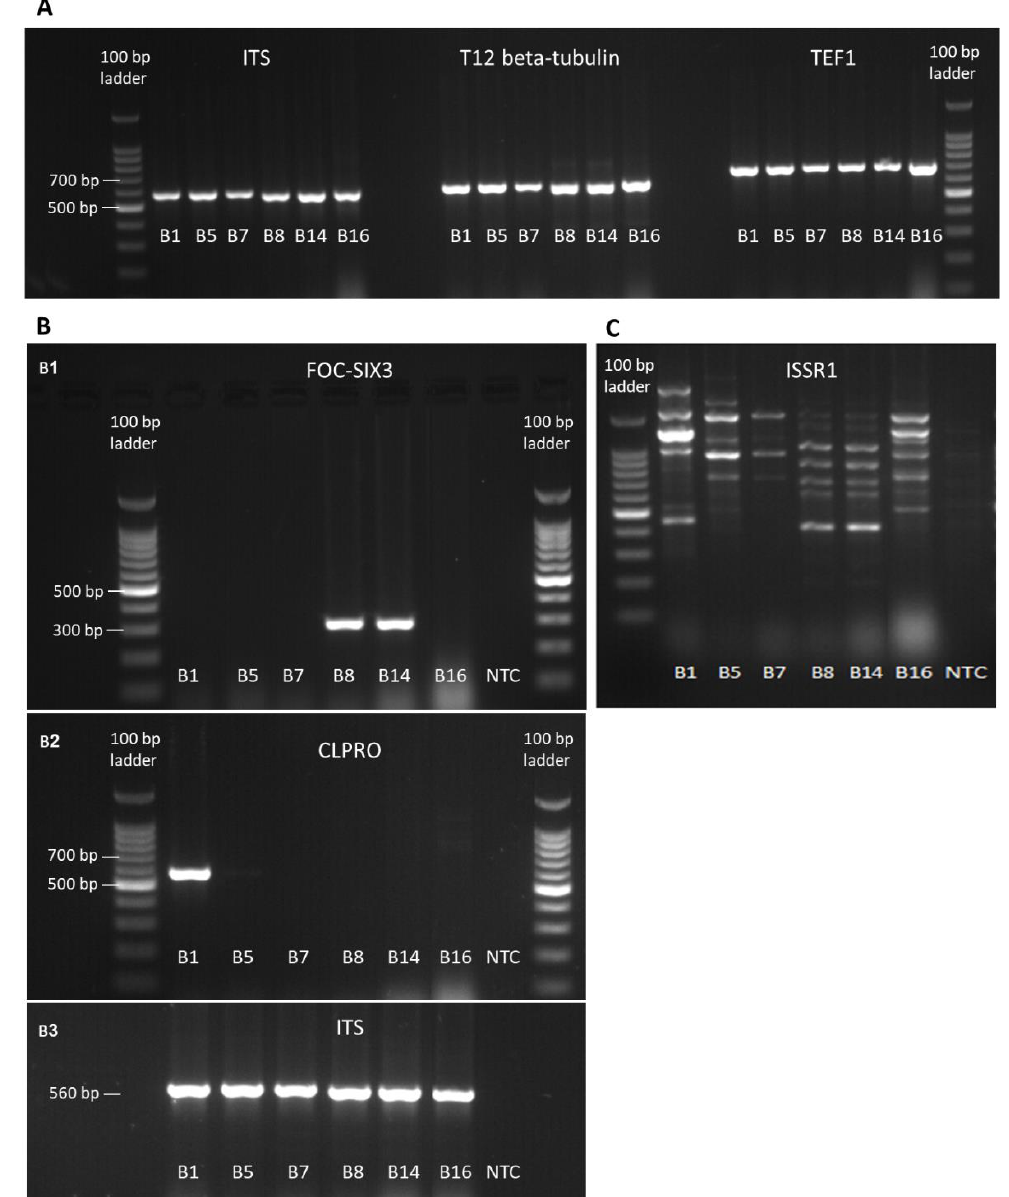
Figure 3. Molecular identification of the Fusarium spp. isolates. Molecular identification of Fusarium species by PCR amplification of the small subunit ribosomal RNA gene, internal transcribed spacer (ITS), the T12 beta-tubulin gene, the translation elongation factor-1 alpha (TEF1) gene ( A ), the Fusarium oxysporum f. sp. cepae (FOC) secreted in xylem genes 3 (SIX3) ( B1 ), and the Fusarium proliferatum partial calmodulin gene (CLPRO) ( B2 ). In the last two target genes, the ITS was used as a positive control ( B3 ). Complex band profile (DNA fingerprinting) generated using the ISSR primers ( C ). Primer sets and reference to the sequences used are given in Table 1. NTC—no-template negative control in which sterile double-distilled water (DDW) was added instead of the DNA